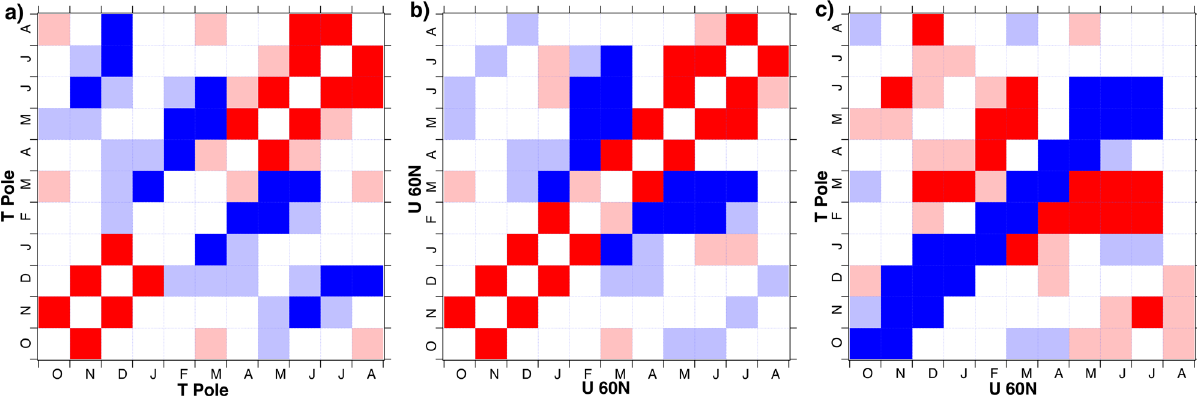
Fig. 4 Correlation between the polar temperature and the zonal wind. Con fi dence level of the correlation between the monthly mean values of 2 months of the year for: a temperature-temperature, b wind-wind and c temperature-wind correlations. + 1 to + 2 SD (standard deviation) light red, > + 2 SD dark red, − 2 to − 1 SD light blue, < − 2 SD dark blue. For correlation between two months of the same variable (Fig. 4a, b), the diagonal is left blank and the fi gure is symmetrical in relation to the